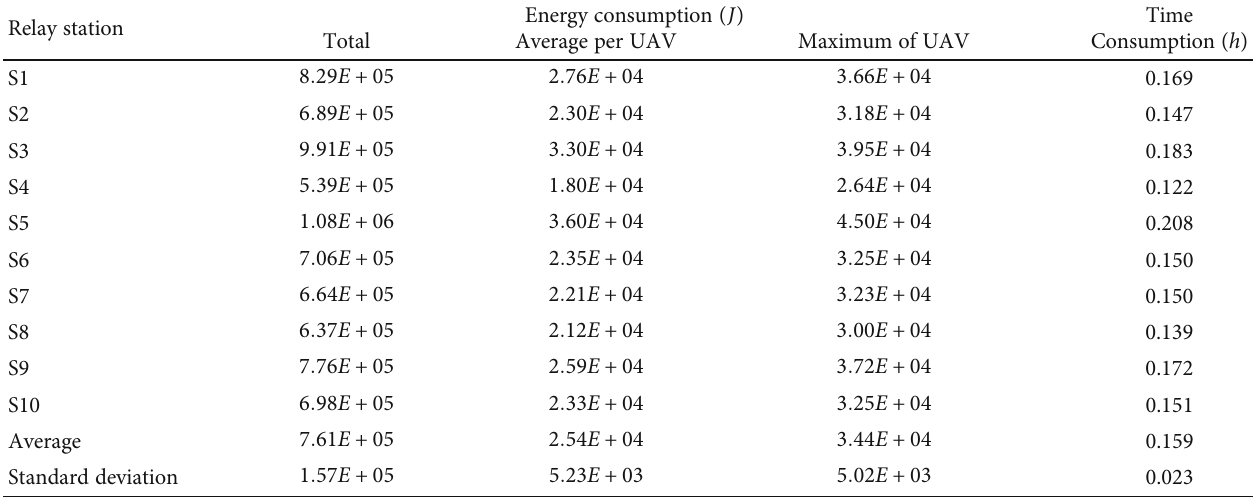
Table 5: The experimental results of 10 relay stations in the complex cooperative task.